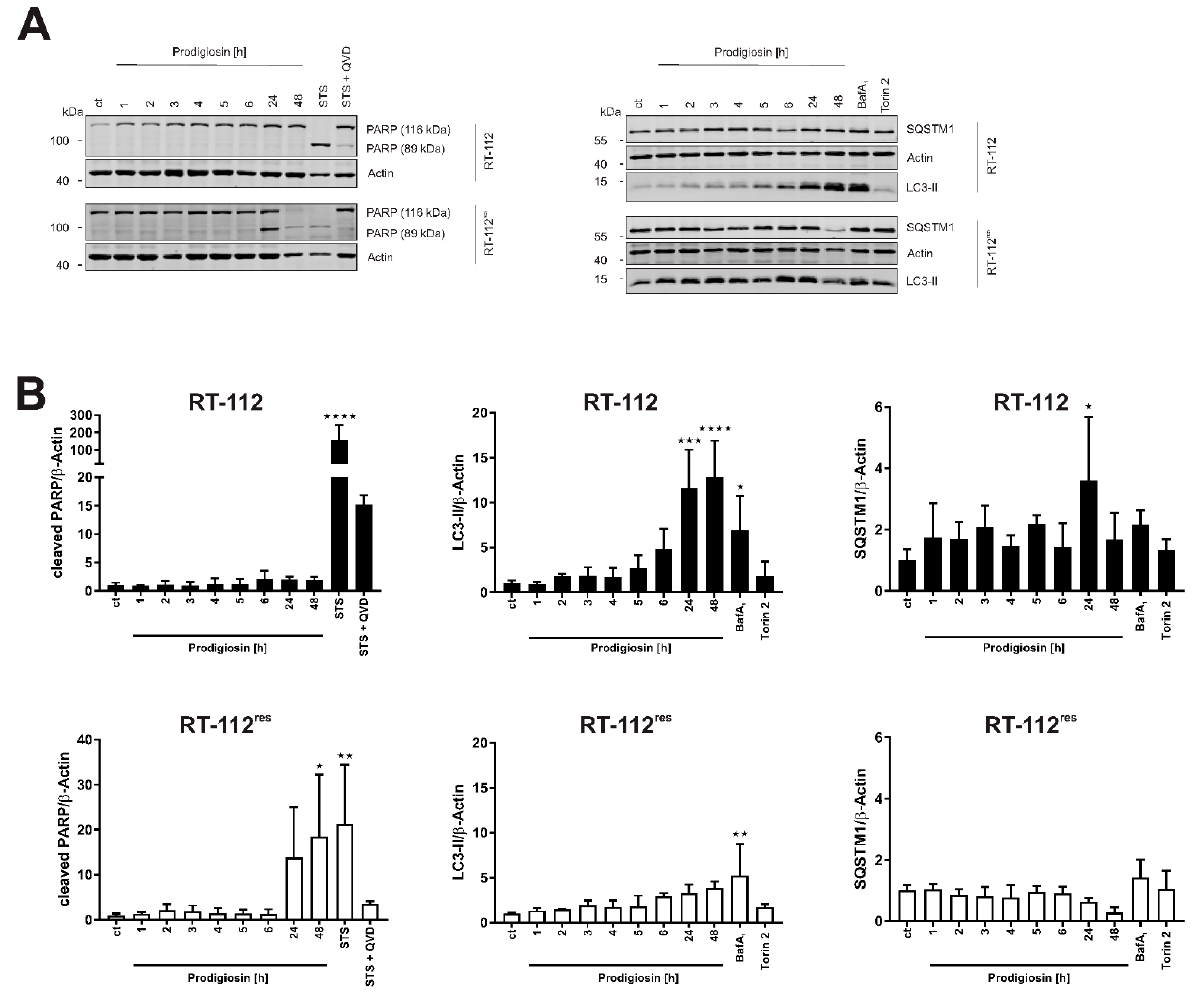
Figure 4. Prodigiosin blocks autophagy in RT - 112 and RT-112 res and induces apoptosis in RT - 112 res in a time-dependent manner. ( A ) RT - 112 and RT - 112 res cells were treated with 100 nM prodigiosin for the indicated periods of time or with 2.5 µM STS ± 10 µM QVD, 10 nM BafA1 or 250 nM Torin 2 for 24 h. After the incubation, cells were lysed, and cellular lysates were immunoblotted for the indicated proteins. One representative immunoblot is shown for each experiment. ( B ) The densities of bands of each protein of at least three independent experiments were quantified and normalized to actin. The mean of the solvent control of RT - 112 (black bars) and RT - 112 res (white bars) was set as 1 for each protein. Bars represent the means + SD. P values were determined by ordinary one-way ANOVA with Dunnett´s post hoc test. * p < 0.05; ** p < 0.01; *** p < 0.001; **** p < 0.0001. PARP: poly (ADP-ribose) polymerase; SQSTM1: sequestosome 1; LC3: light chain 3.